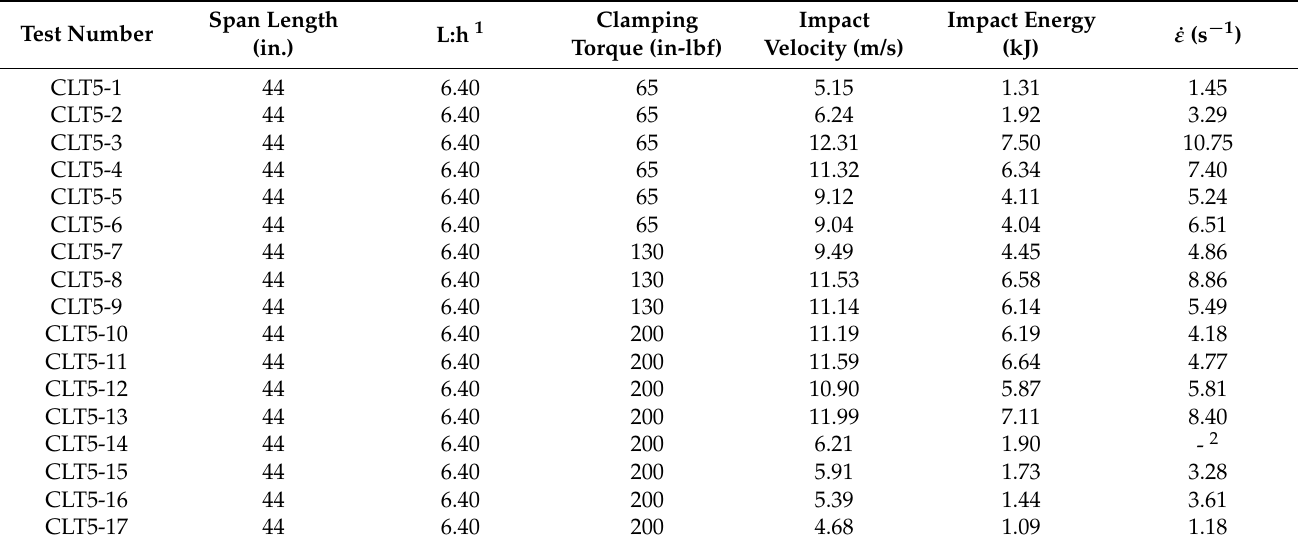
Table 2. Impulsive Center-Point Test Matrix for Five-Laminae